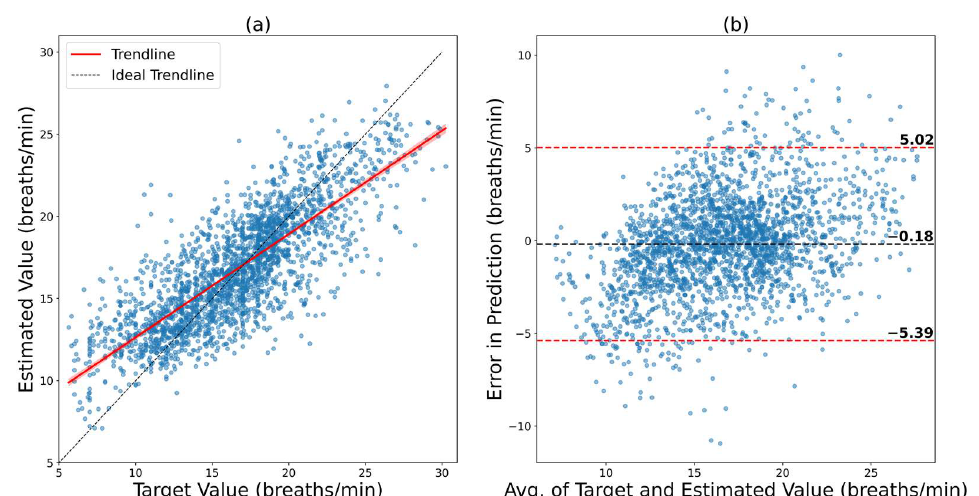
Figure 6. Results of ConvMixer, which was trained on BIDMC and later fine-tuned on the VORTAL dataset. ( a ) Regression plot that shows how close the trendline is to the ideal trendline. ( b ) Bland– Altman plot that shows the 95% confidence interval of the error.